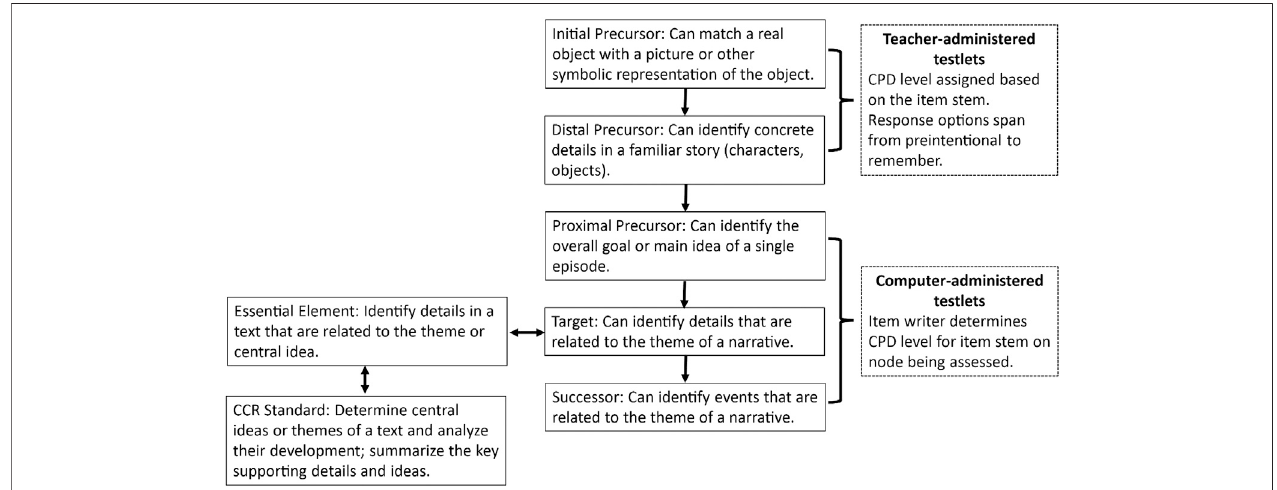
FIGURE 4 | Grade 6 example of content relationships and use of CPD taxonomy in item